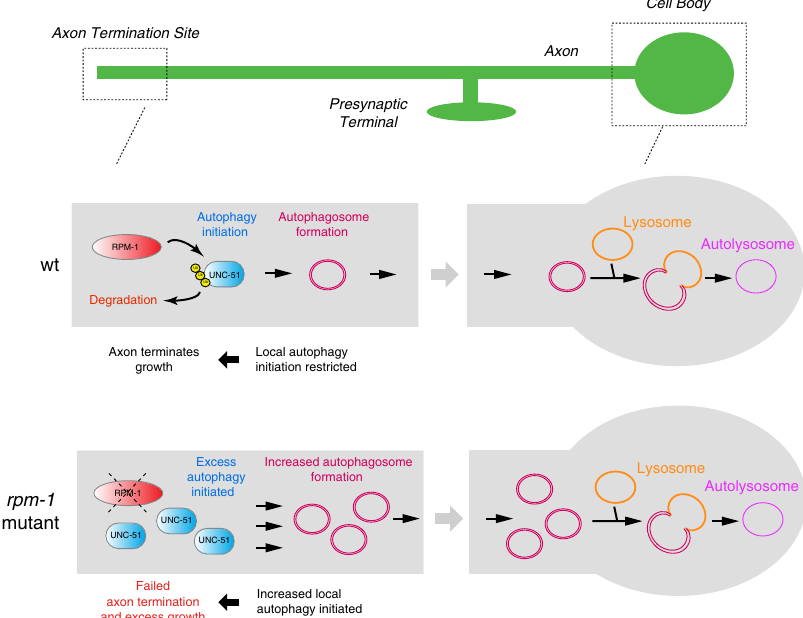
Fig. 9 RPM-1 ubiquitin ligase activity spatially restricts UNC-51 to inhibit initiation of autophagy in neurons. Summary showing RPM-1 ubiquitin ligase activity restricts the autophagy initiating kinase UNC-51 and autophagosome formation at axon termination sites in vivo. Autophagosomes are transported back to the cell body where they form autolysosomes. In neurons lacking rpm-1 , UNC-51 levels are elevated in speci fi c axonal compartments. This leads to excess autophagy initiation, increased autophagosome formation, and failed axon